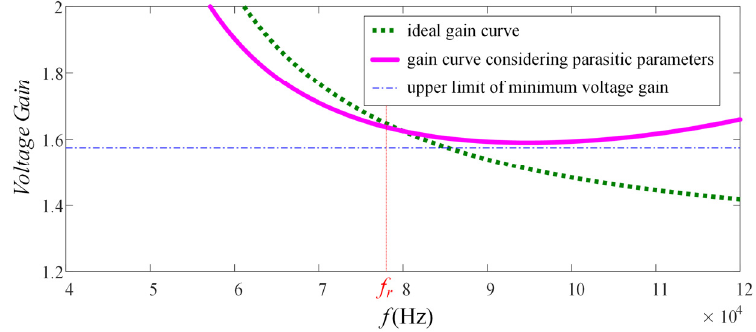
Figure 4. Voltage gain curve of full-bridge LLC converter at light load condition.